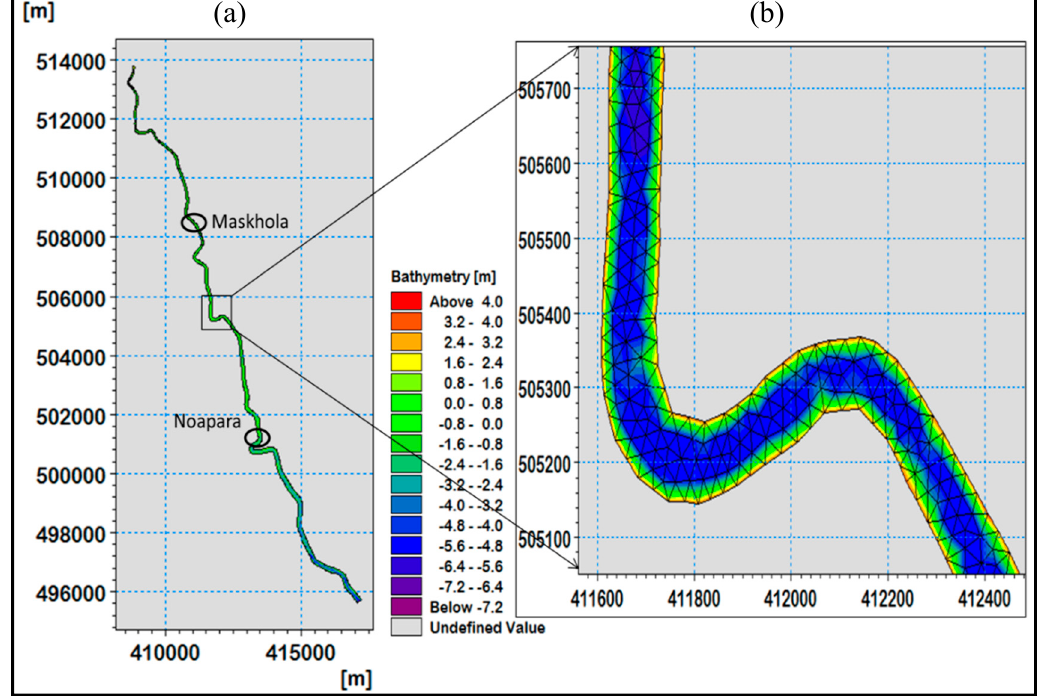
Figure 2. Bathymetry ( a ) and mesh ( b ) for the hydrodynamic model of the Betna River.